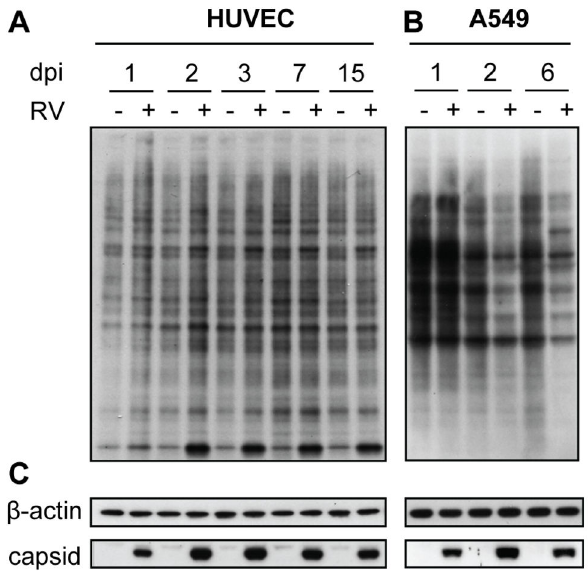
Figure 3. Lack of global cellular protein synthesis shut-off in infected HUVEC. HUVEC and A549 cells were